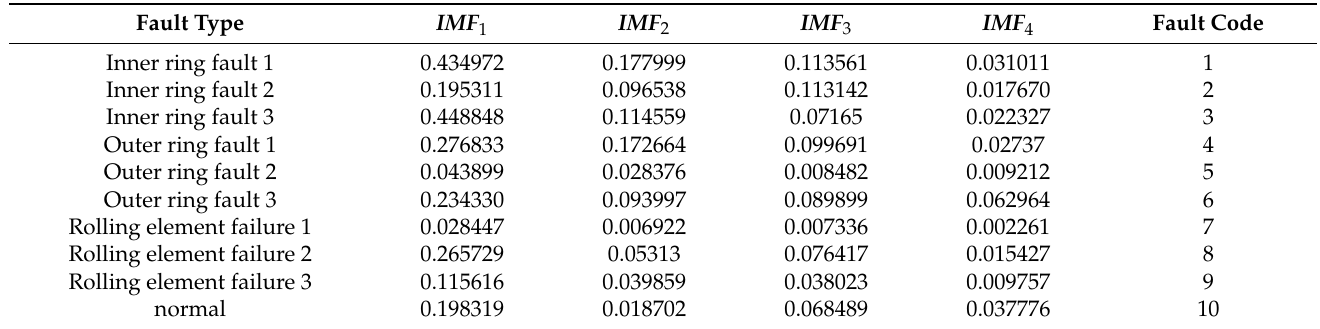
Table 3. IMF Component Fuzzy Entropy of CEEMDAN